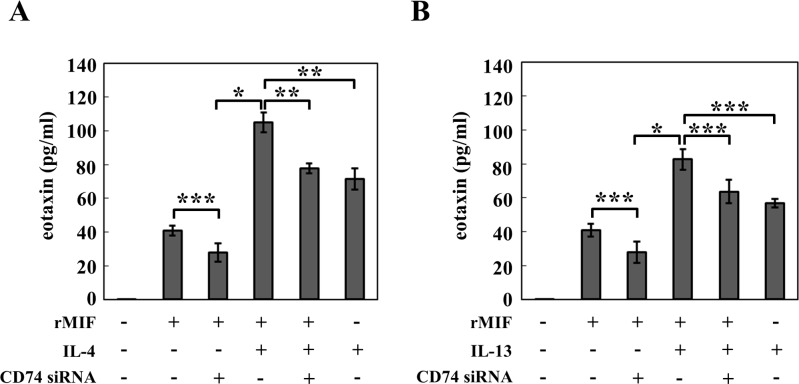
CD74 siRNA transfection inhibits MIF-induced eotaxin protein production by cultured fibroblasts from WT mice.CD74-specific siRNA was transfected into cultured mouse fibroblasts at a concentration of 1 μM. Forty-eight hours after transfection, the cells were stimulated with (A) IL-4 (10 ng ml-1), (B) IL-13 (10 ng ml-1) and MIF (100 ng ml-1) alone or in combination for 24 hours. The eotaxin content of the culture supernatants was analyzed by ELISA. The data are from a representative experiment that was repeated three times and yielded similar results. Each value represents the mean ±SD of three specimens. *P<0.001, **P<0.01, ***P<0.05. The Student's t-test was used.